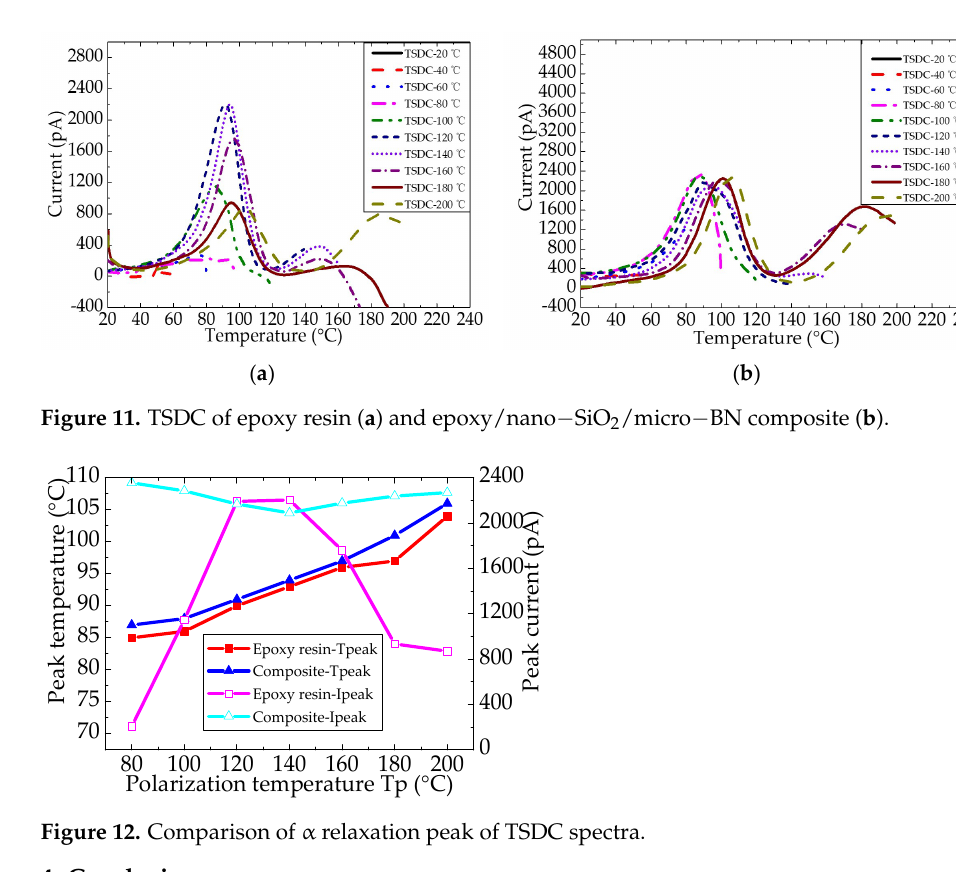
( b ) Figure 10. Real part (ε r ′) and imaginary part (ε r ″) of the complex permittivity of epoxy resin ( a ) and its composite ( b ) at different temperatures. 3.5. TSDC (Thermally Stimulated Discharge Current)